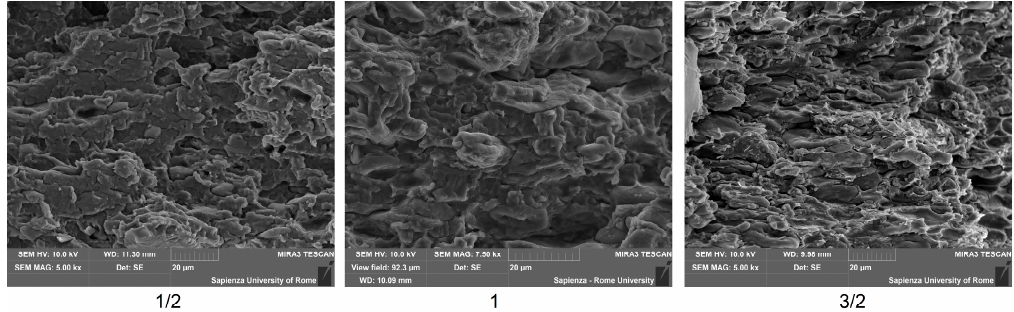
Figure 10. Occurrence of di ff erential deformation in the various composites.